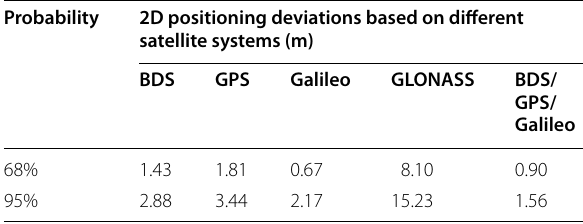
Fig. 14 Numbers of visible satellites and GDOP values of four systems in the static test